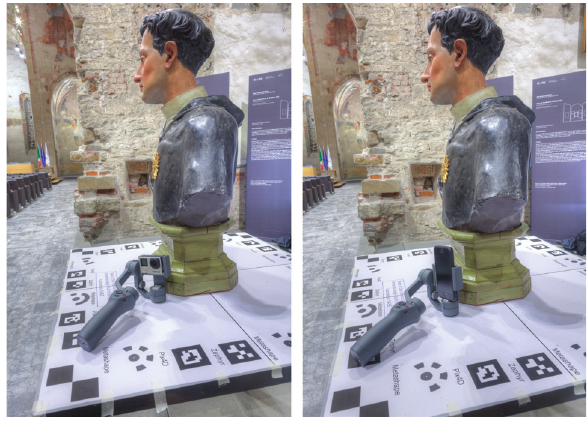
Figure 6. Gimbal and low-cost instruments for video acquisition